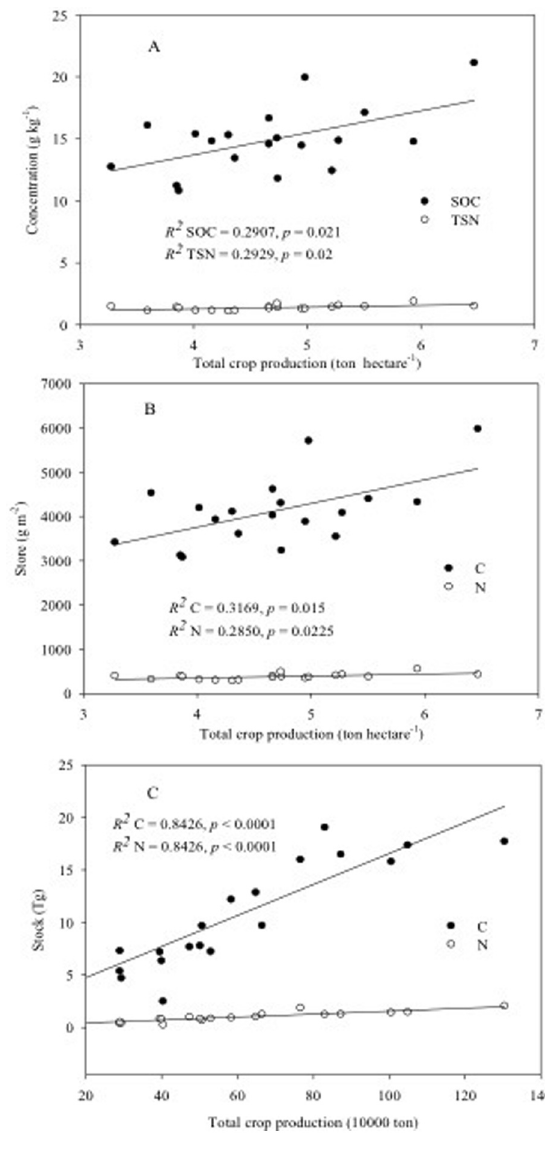
Figure 4. Linear regression analysis of total crop production in each county (ton ha 2 1 ) with SOC and TSN (A) and with soil C and N store (0–40 cm) (B), and the total crop production of each county (10000 ton) with their soil C and N stock (C) (n=19).